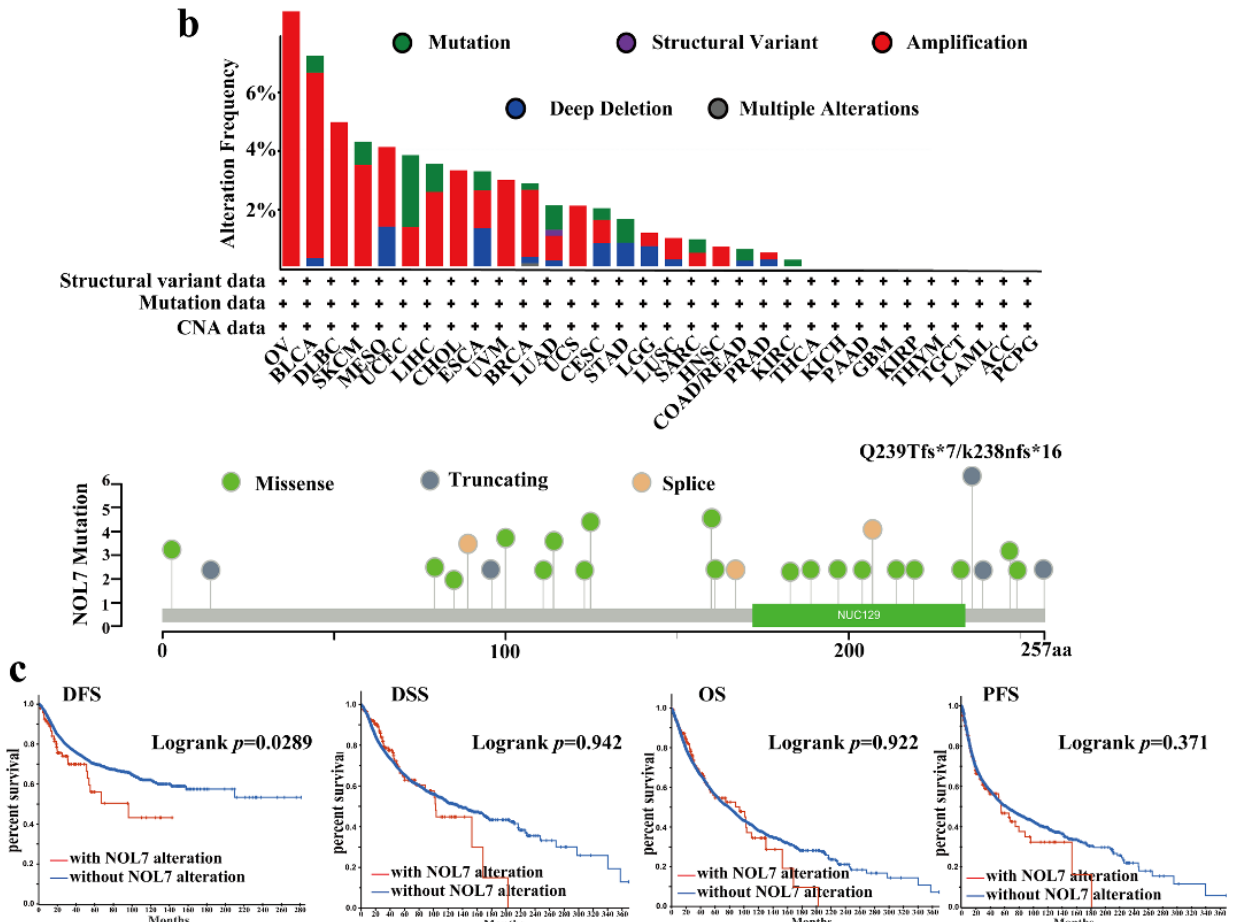
Figure 4. DNA methylation and mutation features of NOL7 in multiple tumors. ( a ) Promoter methylation levels of NOL7 in BLCA, ESCA, HNSC, KIRP, ESCA, LUAD, LUSC, PRAD, PCPG, TGCT, THCA, and UCEC from the UALCAN database. ( b ) Alteration frequencies for different types of mutations of NOL7 in the cBioportal database. The mutation types, sites, and case numbers of NOL7 genetic alterations are shown below. ( c ) The effects of NOL7 mutation status on OS, DFS, DSS, and PFS in cancer patients, according to data in the cBioPortal database. ** p < 0.01; *** p <